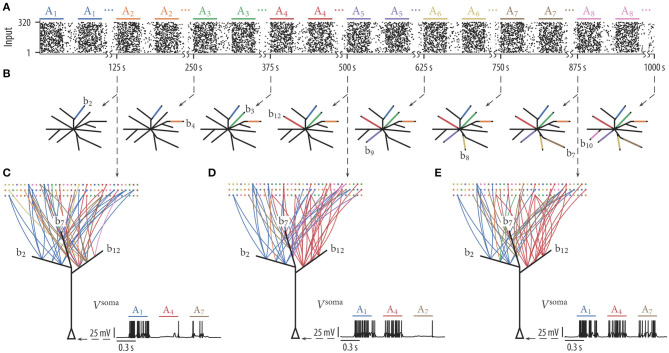
Dendritic-spike-dependent rewiring protects stored information by segregating functionally unrelated inputs onto different dendritic branches. When input assemblies were activated sequentially, novel assemblies clustered on free branches while previously established clusters were retained. (A) Input assemblies Ai activated in a sequential manner. We first activated exclusively assembly A1, then assembly A2, then A3, etc. (B) Schematic drawing of the 12 simulated branches at 8 different time points (branch color indicates assembly origin of synaptic cluster at the branch). Branches were recruited sequentially. (C–E) Network connectivity graph and somatic membrane potential Vsoma of three selected branches (b2, b7, and b12) at three different time points. Graph edge color indicates to which of the input assemblies a connection is established. The somatic potential shows the response of the neuron to one test pattern of assembly A1, assembly A4, and assembly A7. The neuron successively reorganized its synaptic connections such that it responds to any of the patterns that have been presented previously.